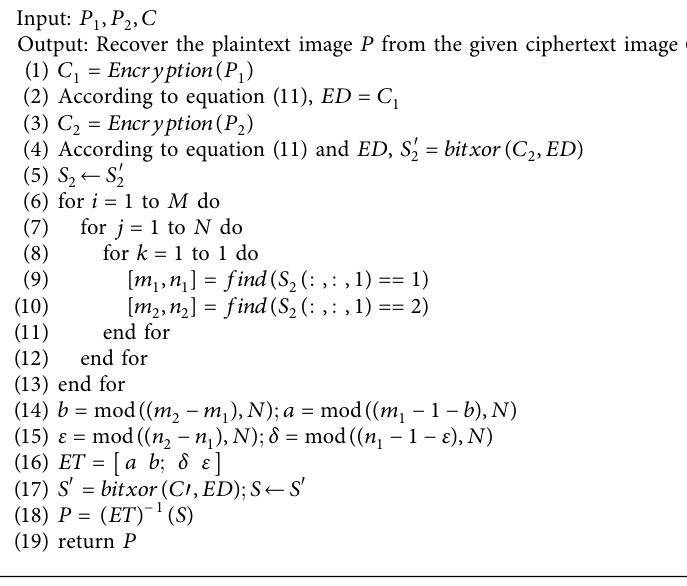
. (b)Its corresponding ciphertextimage C 1